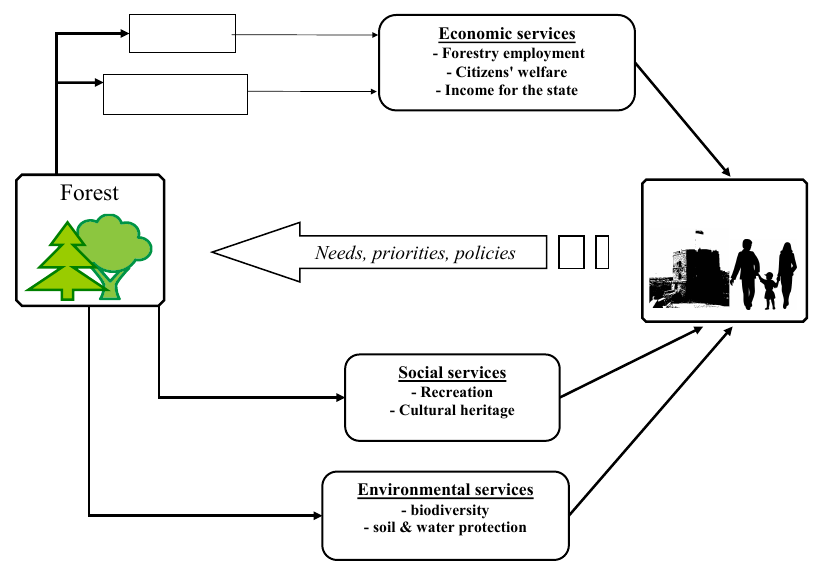
Figure 2. Macro perspective (forestry) in Lithuania.